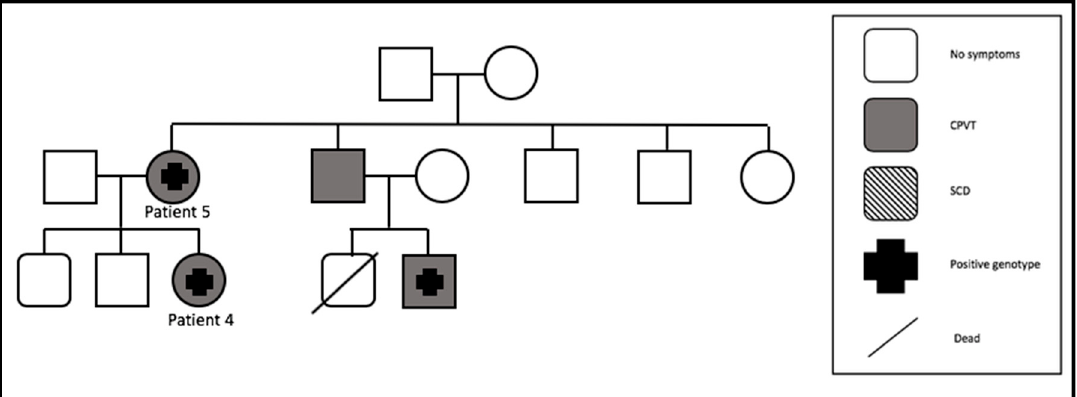
Figure 2. Pedigree of family 3 (SCD = sudden cardiac death).